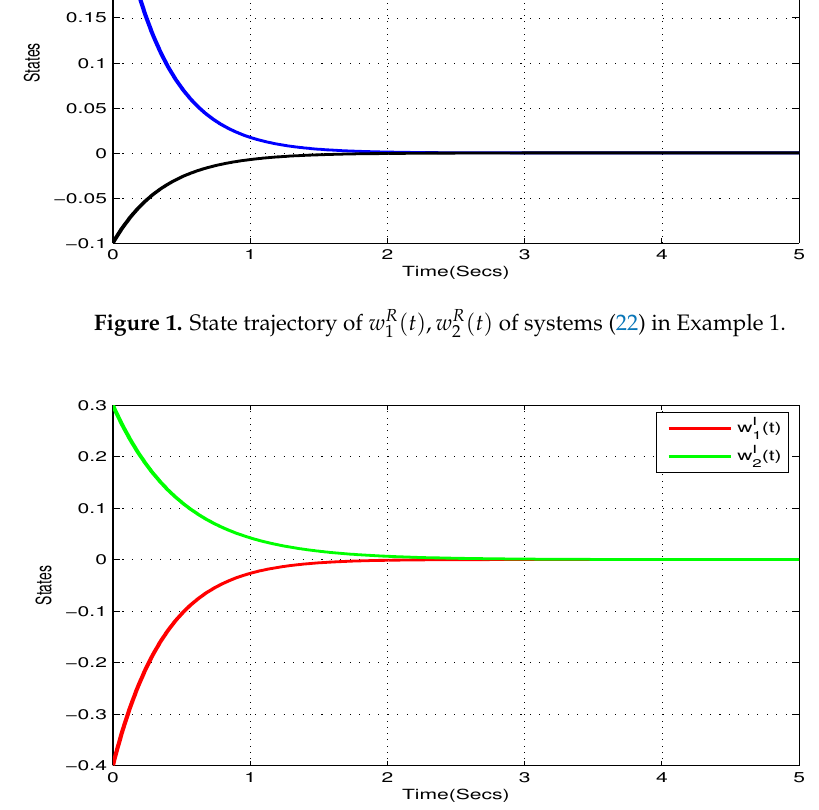
Figure 2. State trajectory of w I